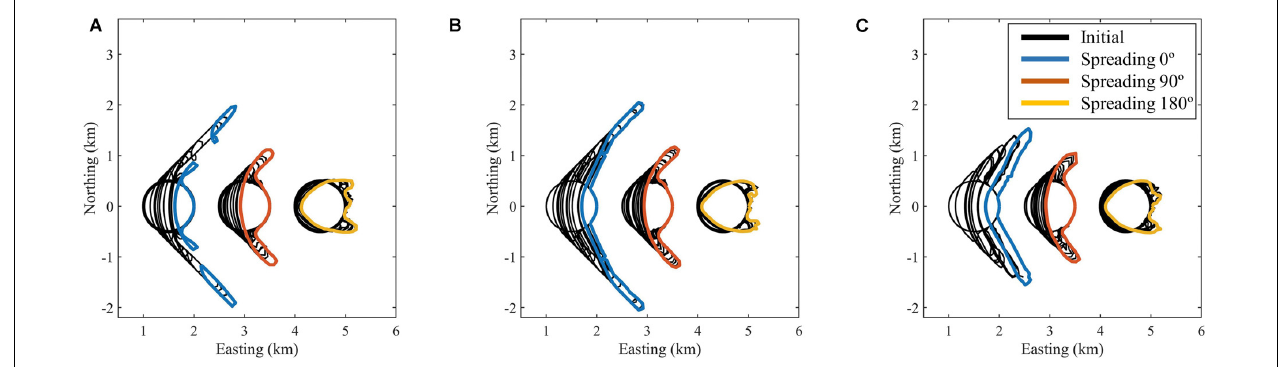
FIGURE 6 | Deformation of an island due to waves with mean direction from the West; wave spreading uniform 0 ◦ , 90 ◦ , and 180 ◦ , respectively. Left panel (A) : no overwash. Middle panel (B) : critical spit width 100 m. Right panel (C) : critical spit width 200 m.